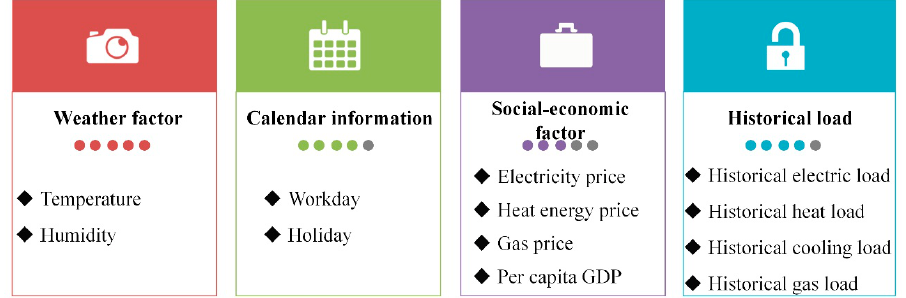
Figure 9. The specific input variables of the uncertain interval prediction model for multi-energy loads. The hourly data of different variables from January 2018 to June 2018 are selected as the training sample, and the hourly data of different variables of July 2018 is treated as the test sample for the established uncertain interval forecasting model of the industrial park’s combined electricity-heat-cooling-gas loads. The data are collected from the Me- teorological Bureau and Energy statistics of the province where the industrial park lo- cated and through site investigation. Additionally, Matlab R2014a is employed for pro- gramming.